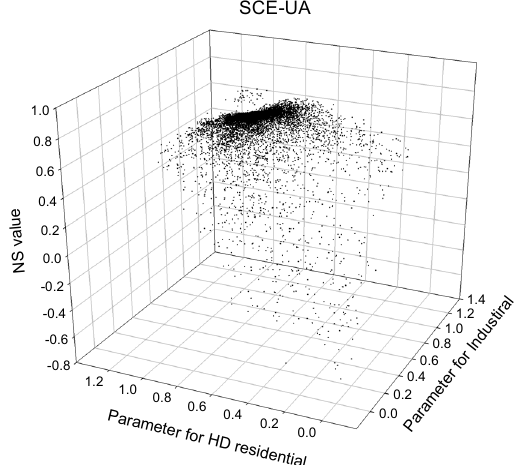
Figure 10. NS values and individuals for two optimized parameters, which are industrial land use (31% of total area) and high residential area (28% of total area) in WD#10, respectively. Number of model runs were 20,000 for SCE-UA and 20,300 (100 individual/generation and 200 generations) for GA. ( a ) NS values for GA; ( b ) NS values for SCE-UA.